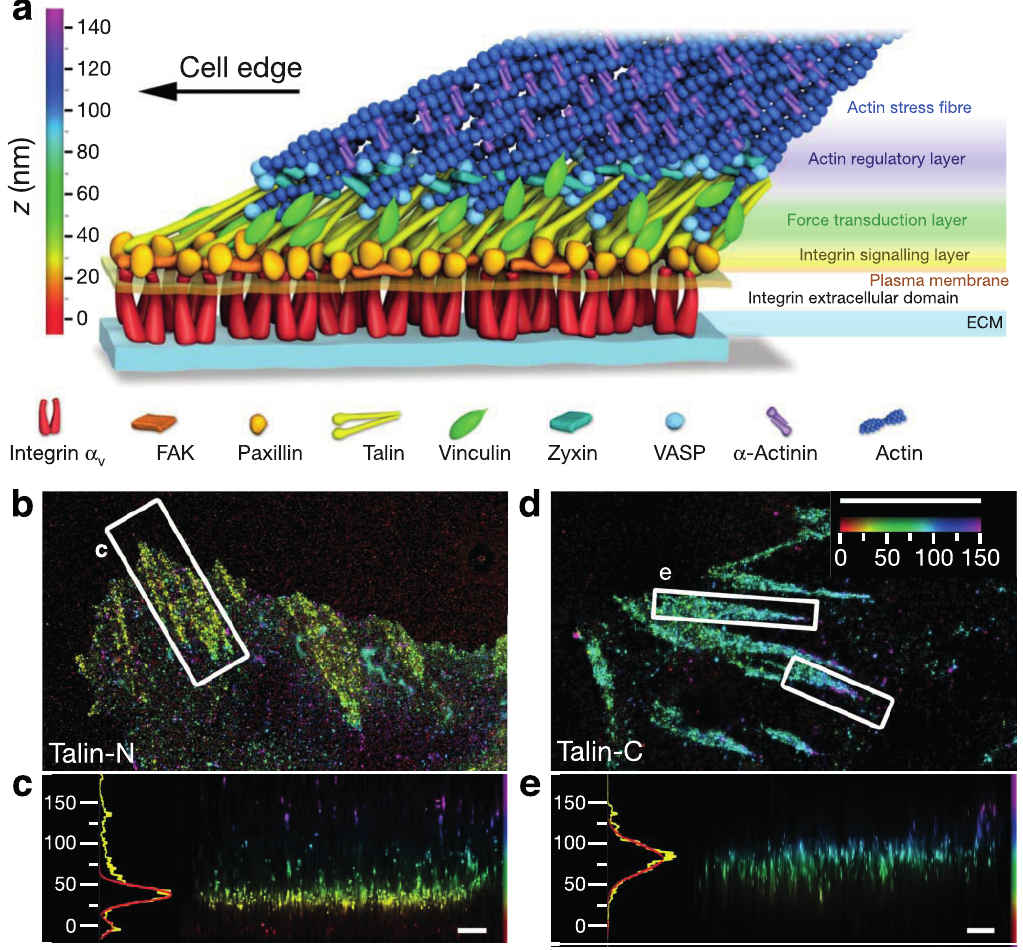
Figure 3. A super-resolution view of membrane associated focal adhesions. ( a ) Schematic model of the molecular architecture of focal adhesions. This model is based on the protein position measurement by interferometric photoactivatable localization microscopy (iPALM). The exquisite sensitivity of iPALM to register axial distances could determine the orientation of talin within focal adhesion. ( b – e ) Top and side views of iPALM images of focal adhesions (white boxes, top-view panels) and corresponding z histograms. Color encodes distance from the coverglass surface in nanometers. Placing the fluorescent probe at the two ends of the talin rod show that the N-terminus of talin rod localizes close to the cytoplasmic tails of integrin ( b , c ), whereas the C-terminus can localize up to 40 nm higher ( d , e ). Scale bars: 5 μm ( b , d ) and 500 nm ( c , e ). Images reproduced with permission from 89. Abbreviations: ECM, extracellular